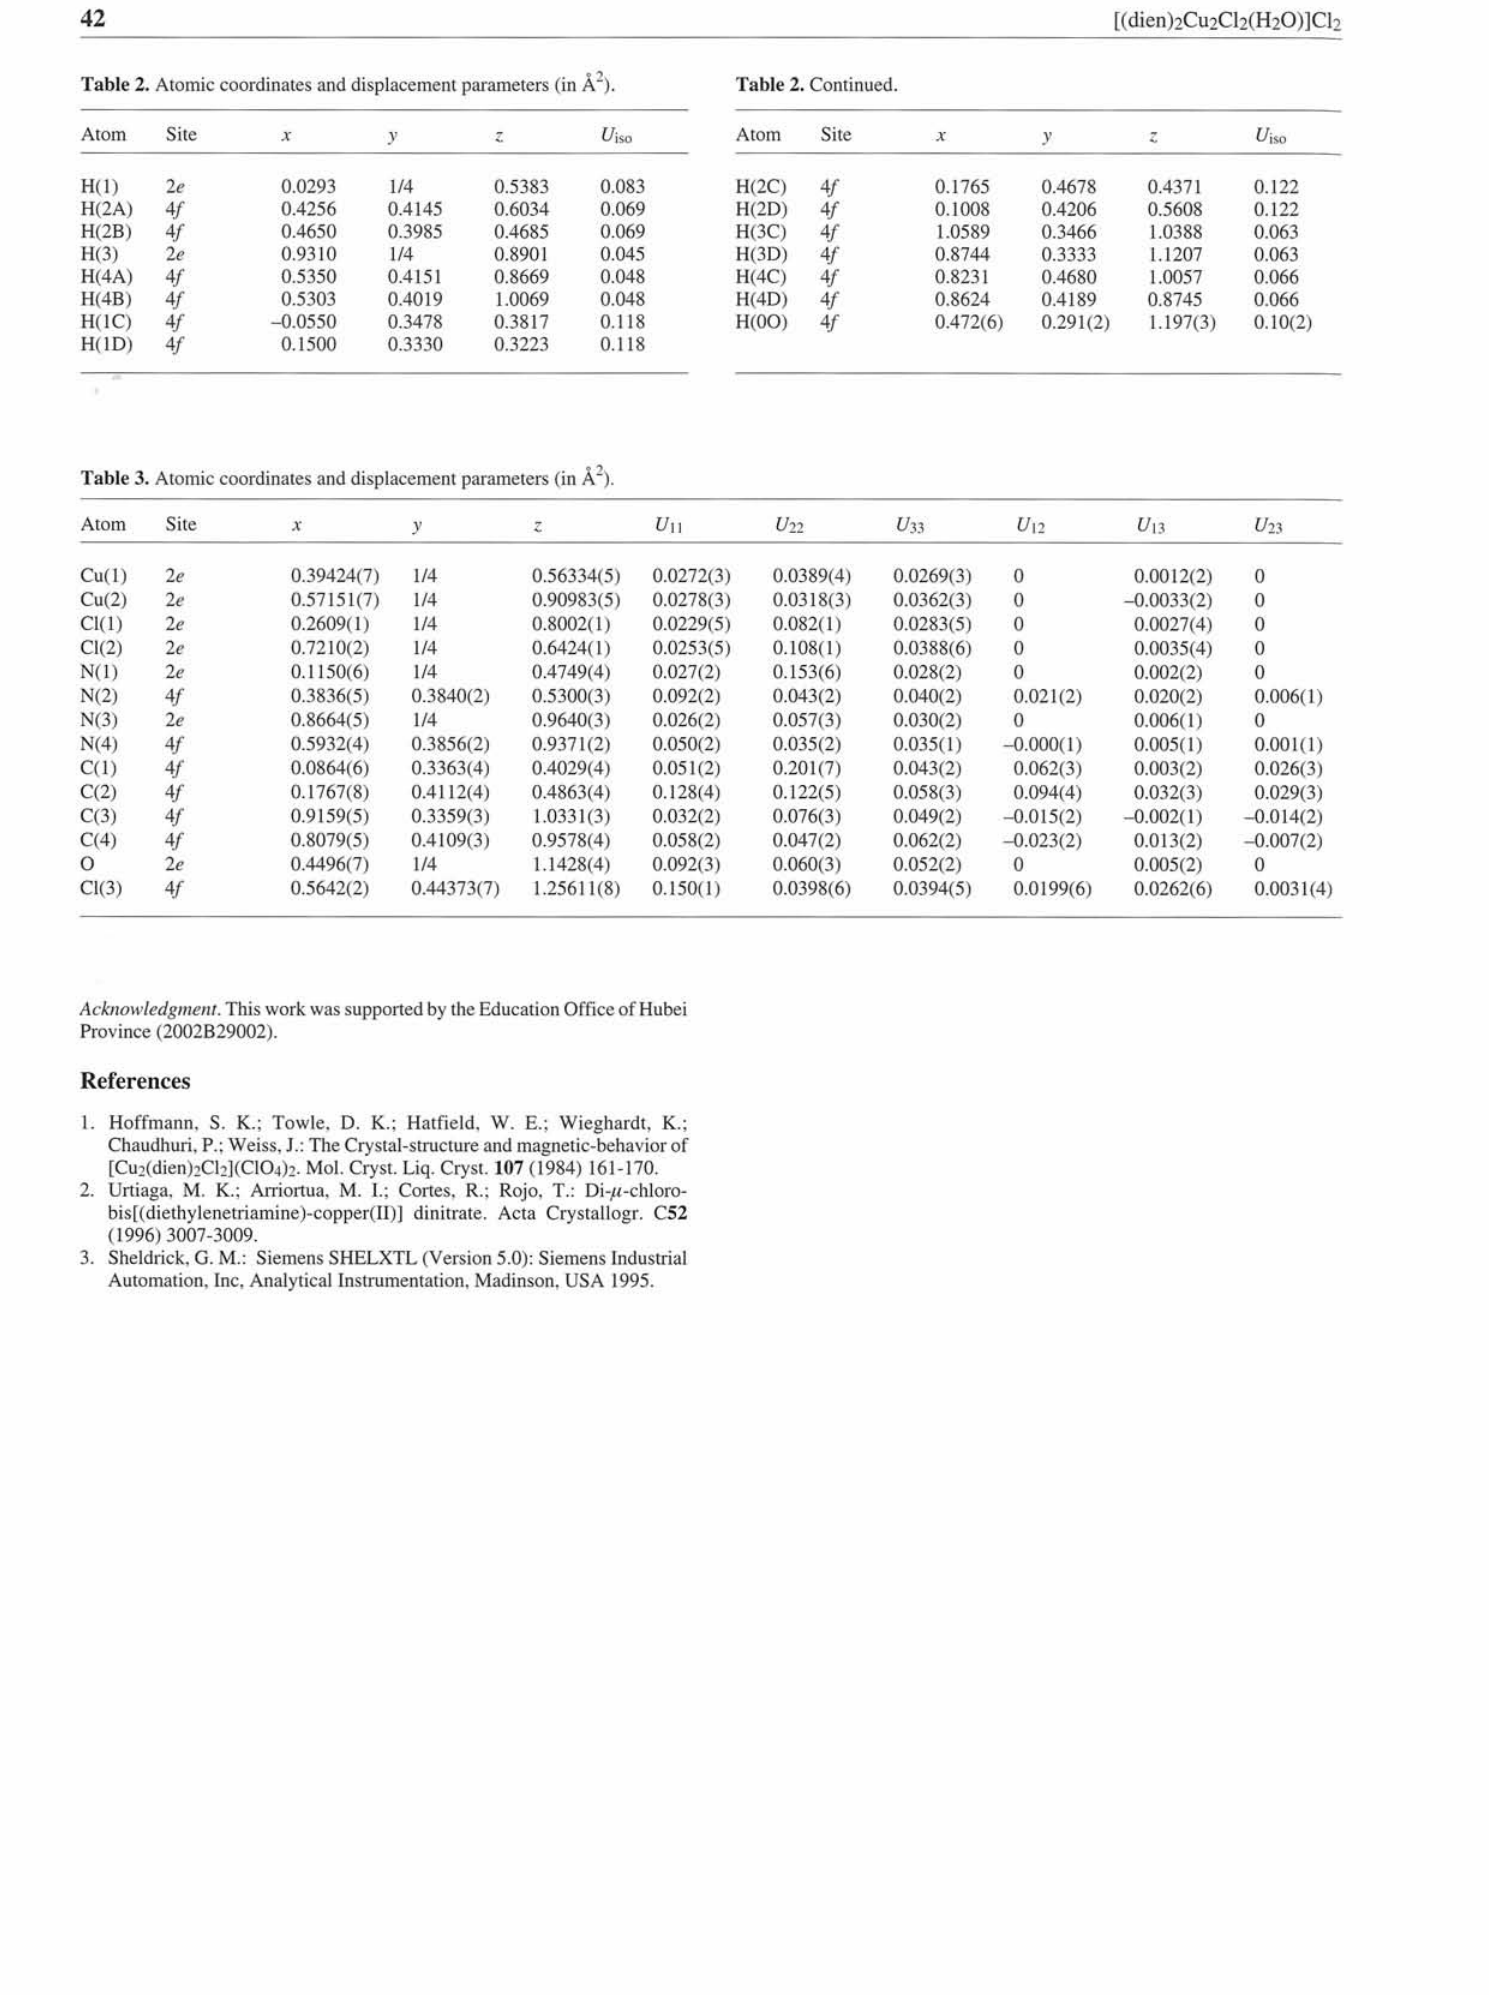
Table 3. Atomic coordinates and displacement parameters (in Â 2